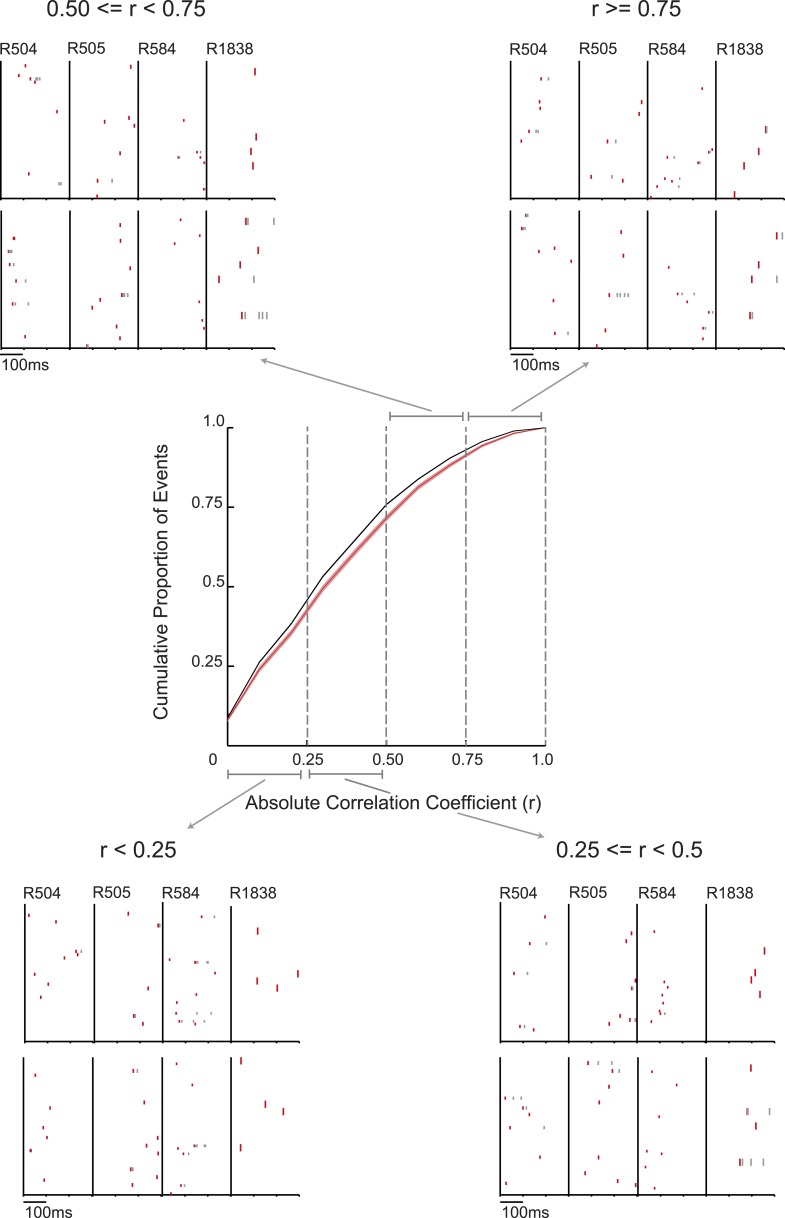
Spiking events for cued arm in REST2 centre: bootstrapped cumulative distribution of (absolute) correlations between spiking events and the cued template in REST2 (red = data, black = shuffle).Lighter areas of the curve show 1 standard deviation of the mean. Raster plots: spiking events of varying correlations with the future cued arm template. The title of each quadrant shows the correlation range for raster plots in that quadrant. Labels above the top row in each quadrant show which animal the spiking events belong to. Red rasters = first spike emitted from a cell in an event, grey rasters = consecutive spikes emitted from a cell.